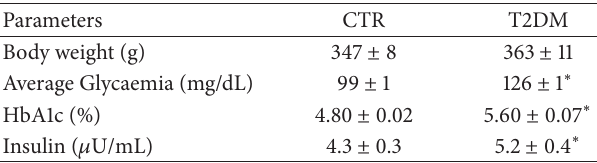
Table 2: Average values of the animals weight, glycaemia, HbA1c, and insulin levels measured in animals from the control (CTR) and T2DM group after three months of